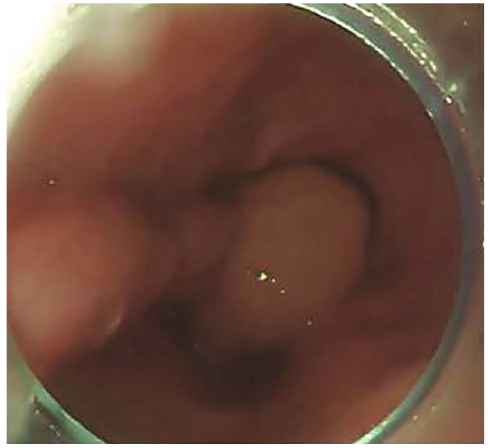
Figure 2: The tumor prolapsed into the esophagus, and the esophageal lumen was dilated. The surface of the tumor was smooth and yellowish-white in color.